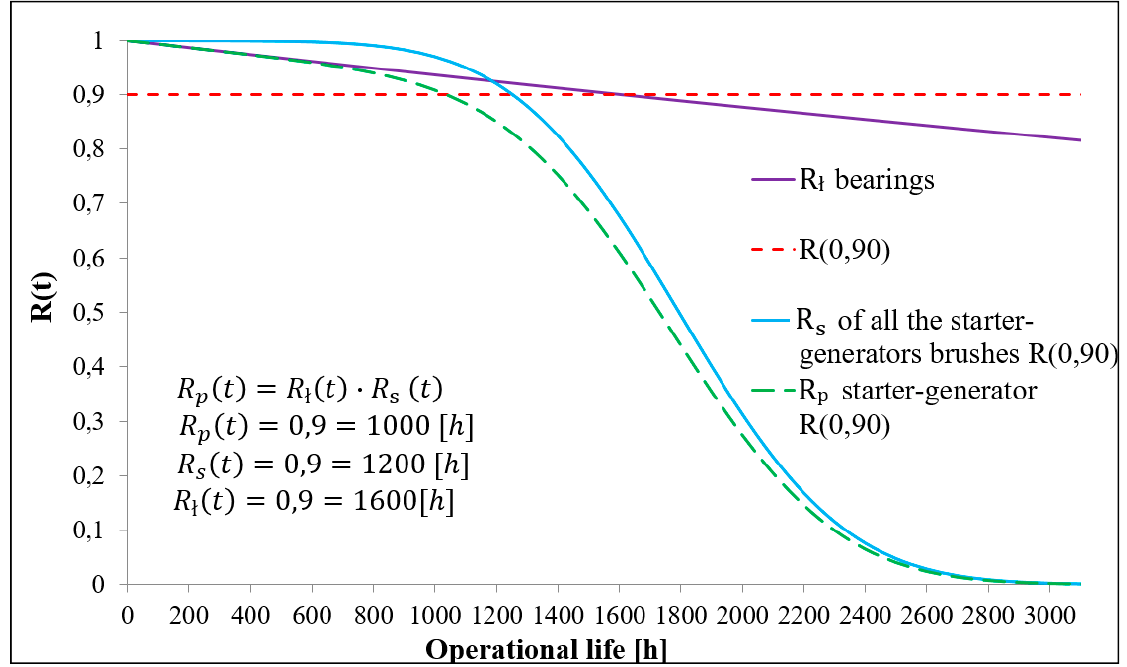
Figure 13. Characteristics of the reliability function 𝑅 (cid:3043) (𝑡) of the starter-generation 200SGL129Q.